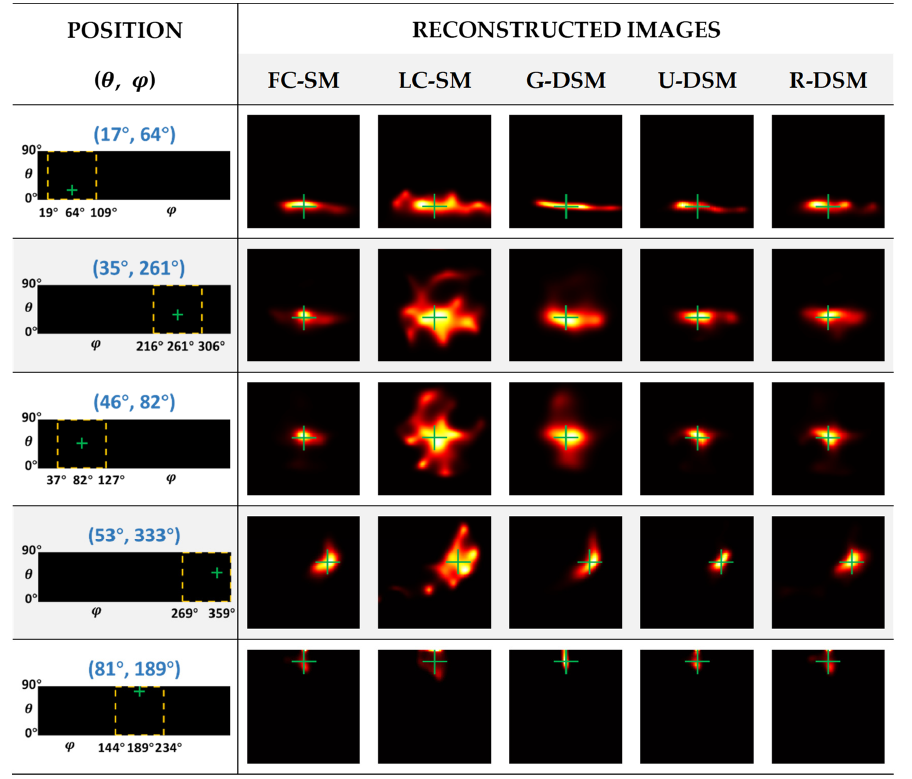
Figure 19. Reconstructed images of different SMs at representative positions for 137 Cs source in inter-device evaluation.